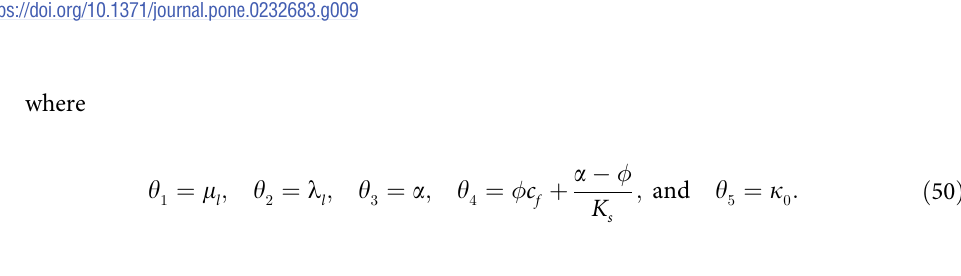
, and MSE are calculated using Eqs 44, 45, 46, and 47, respectively. P u P p